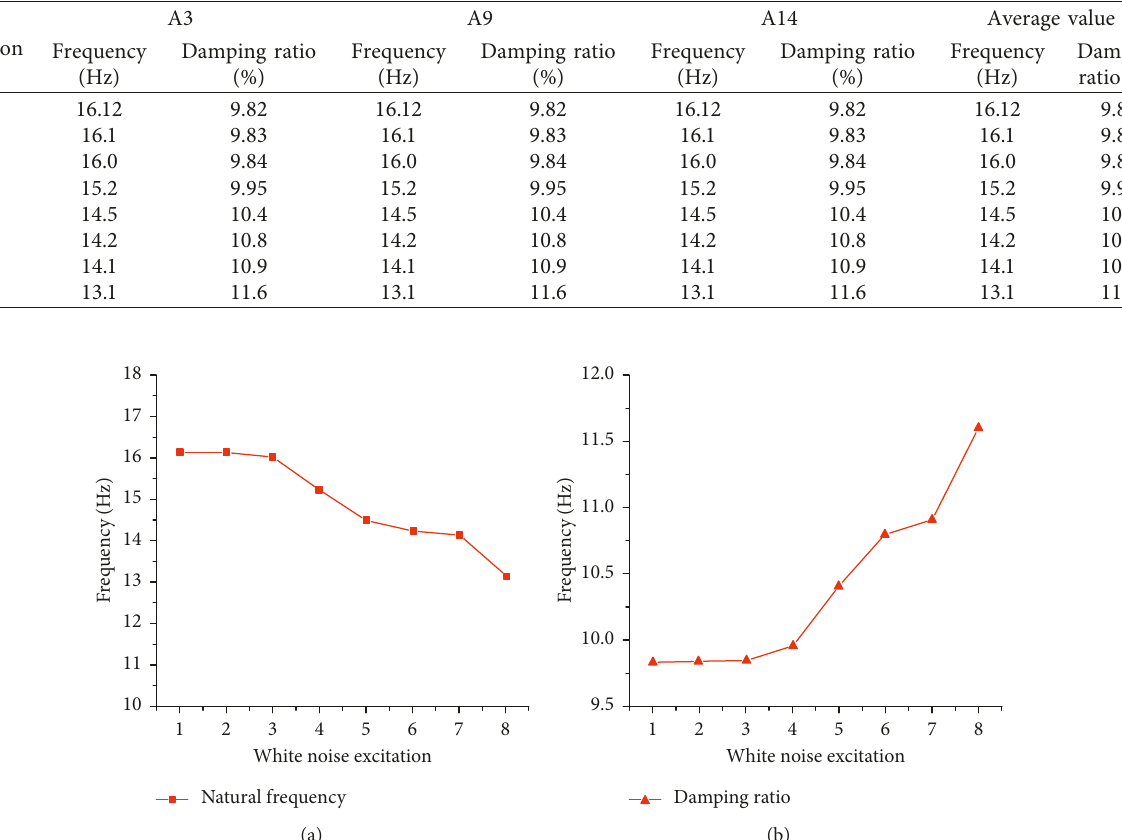
Figure 9: (a) Comparison of acceleration time-history curves between A15 and A1. (b) Comparison of acceleration time-history curves between A16 and A3. Table 6: First-order modal parameters for convex slope internal measurement points.